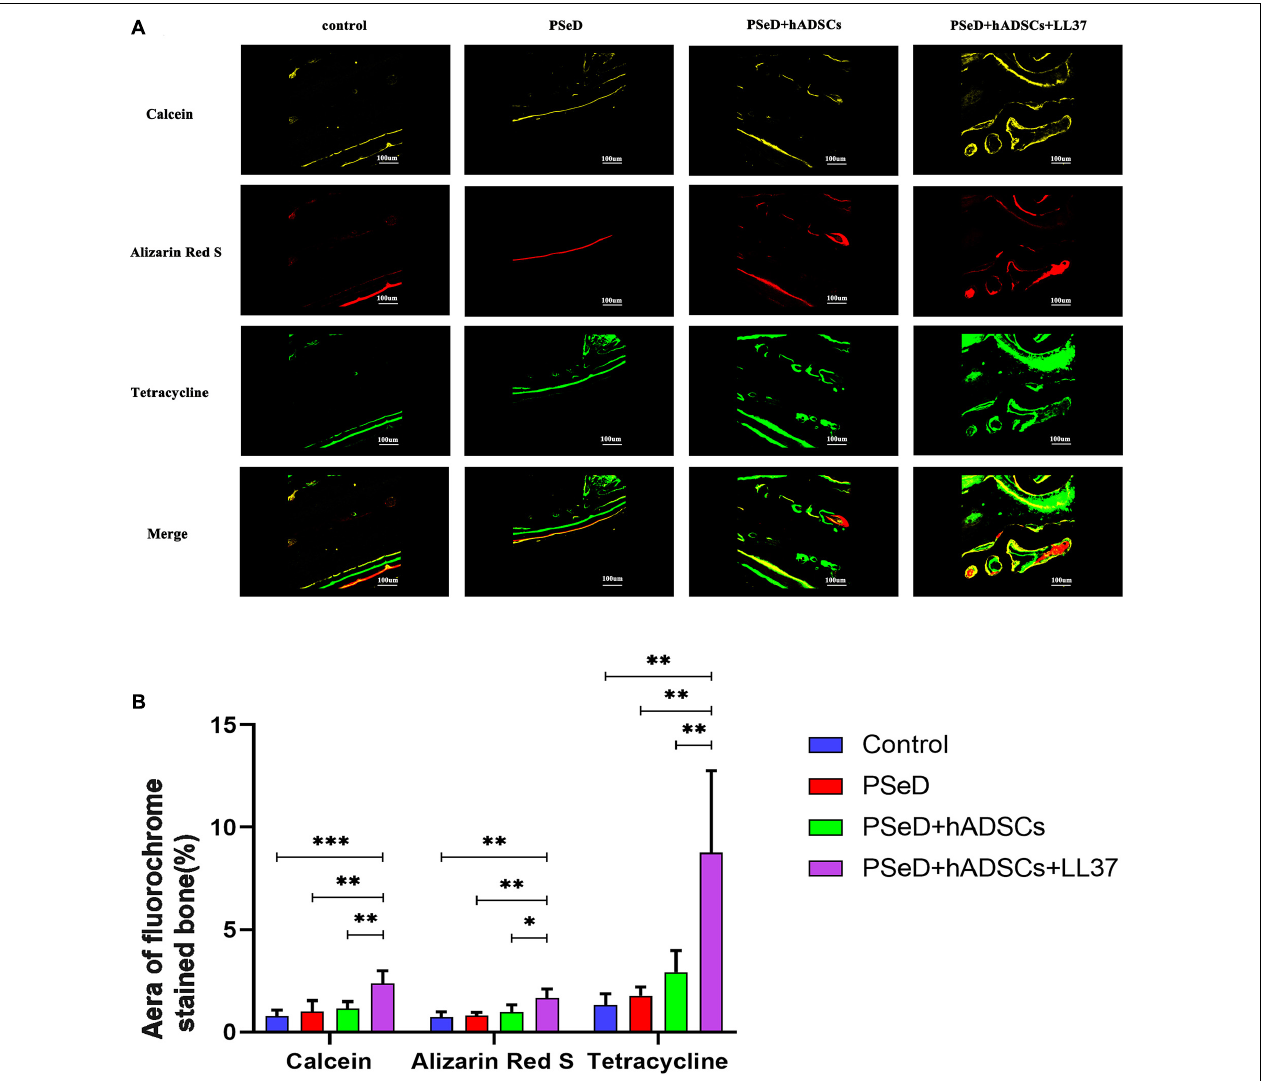
FIGURE 6 | Fluorescence labeling results in new bone formation. (A) Confocal microscope images for each group. Row 1 (yellow) represents new bone formation marked by calcein injected at week 6, row 2 (red) represents alizarin red at week 4, row 3 (green) represents tetracycline at week 2, and row 4 represents merged images of the three fluorochromes for the same group. (B) The graph shows the percentages of each fluorochrome area for the different groups. Significant differences were observed between PSeD/hADSCs/LL37 group and PSeD/hADSCs group ( n = 6, unpaired t -test, ∗ p < 0.05, ∗∗ p < 0.01, ∗∗∗ p <